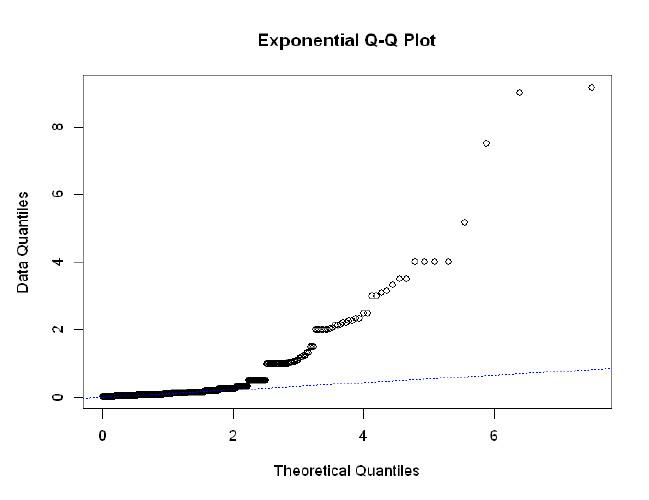
Figure 6. Exponential Q-Q plot of interarrival time between 2 occurring claims in Group 2.